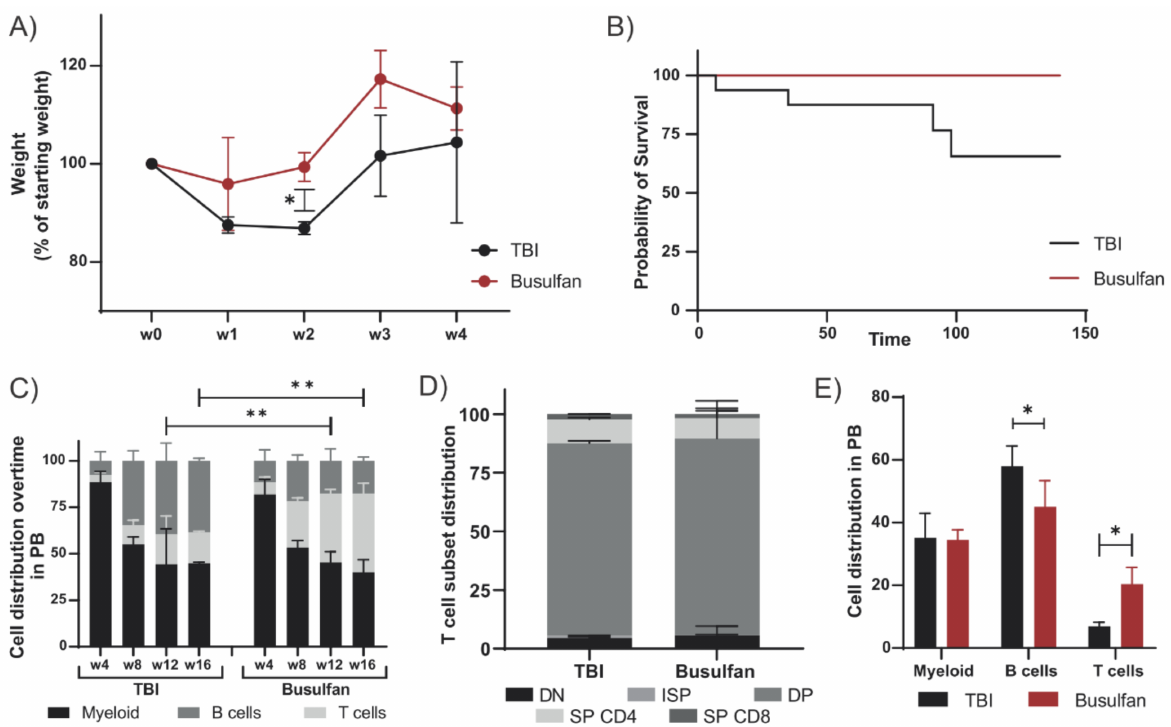
Figure 1. Busulfan conditioning as an alternative to TBI in immunodeficient mice: Rag2 − / − mice transplanted with wild-type BALB/c HSPCs were preconditioned by total body irradiation (TBI, 8.09 Gy) or busulfan (50 mg/kg). Immune reconstitution was analyzed up to 20 weeks after transplantation. ( A ) Mice were weighed weekly during the first month after transplantation. Change of weight normalized to the starting weight before conditioning is depicted in the graph for TBI (2 mice) and busulfan (3 mice) treated mice. (Unpaired t-test; * p < 0.05). ( B ) Survival analysis of the TBI-conditioned (16 mice from historical data) and busulfan-conditioned mice after transplantation (4 mice). ( C ) Cell distribution (myeloid, B and T cell) in peripheral blood (PB) over time of mice preconditioned with TBI (2 mice) or busulfan (4 mice). (Two-way ANOVA; ** p < 0.01). ( D ) Proportion of the different T-cell developmental subsets in the thymus after TBI or busulfan conditioning. ( E ) Cell distribution (myeloid, B and T cells) in PB 20 weeks after transplantation. (Two-way ANOVA; * p <